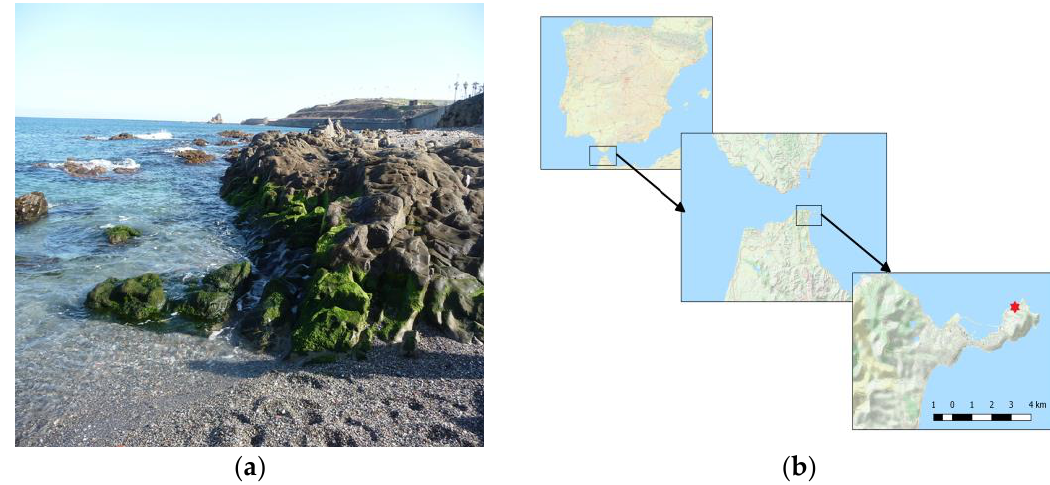
Figure 1. Type locality of B. transfretana ( a ) Playa Punta Sauciño in Ceuta, N. Africa; ( b ) location of the study site (red